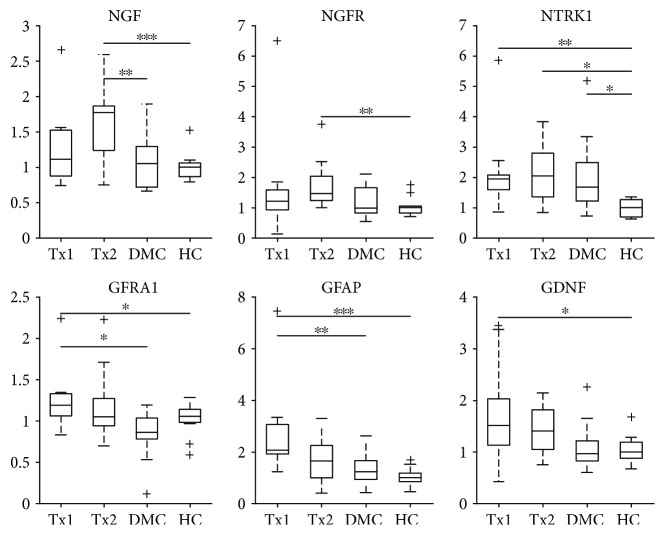
Relative expression of six differently expressed factors. Data are shown as median and 1st and 3rd quartile. Differences between individual groups were assessed by Wilcoxon test with Bonferroni correction: ∗
p < 0.05; ∗∗
p < 0.01; ∗∗∗
p < 0.001. NGF: nerve growth factor, NGFR: NGF receptor, NTRK1: neurotrophic receptor tyrosine kinase 1, GDNF: glial cell-derived neurotrophic factor, GFRA1: GDNF family receptor alpha 1, GFAP: glial fibrillary acidic protein. +: outlying values.